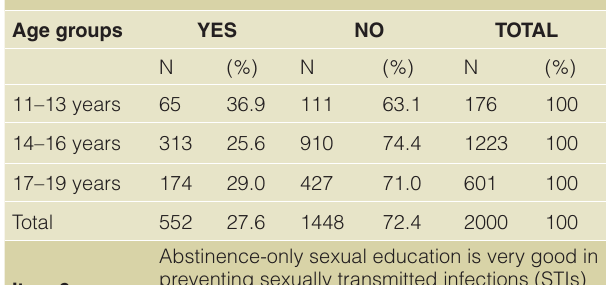
Table 2. Perspective of adolescents according to age group on the advantages of abstinence-only sexual education. Item 1